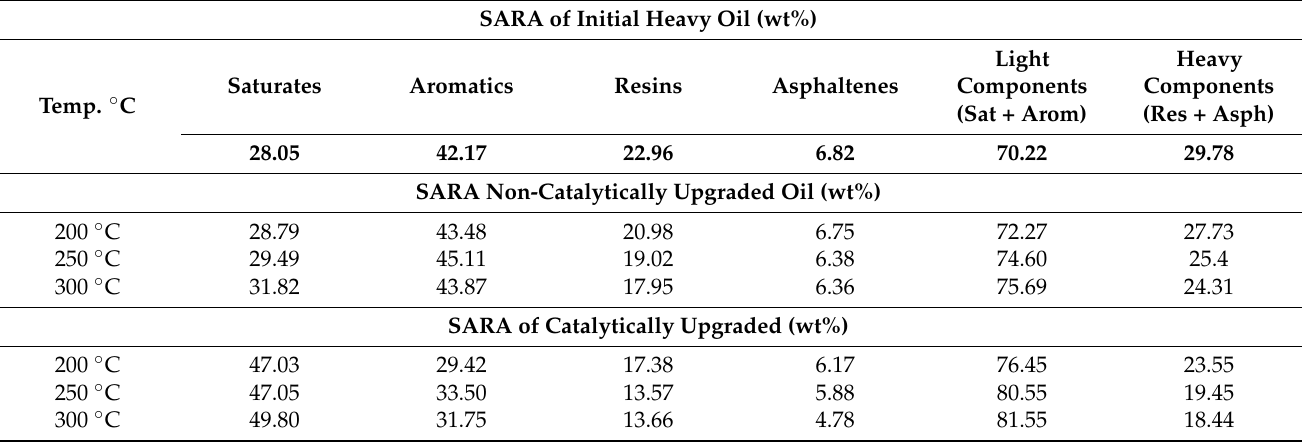
Table 3. SARA analysis of the upgraded heavy oil in the presence and absence of MoOHC catalyst. SARA of Initial Heavy Oil